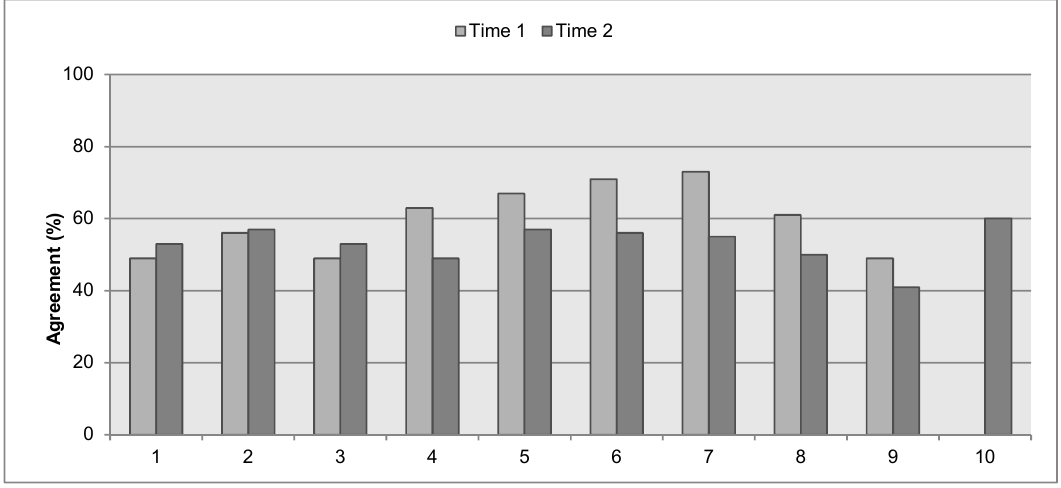
Figure 1: Graph of assessors’ percentage of agreement for each client’s total script at 2 times of assessments